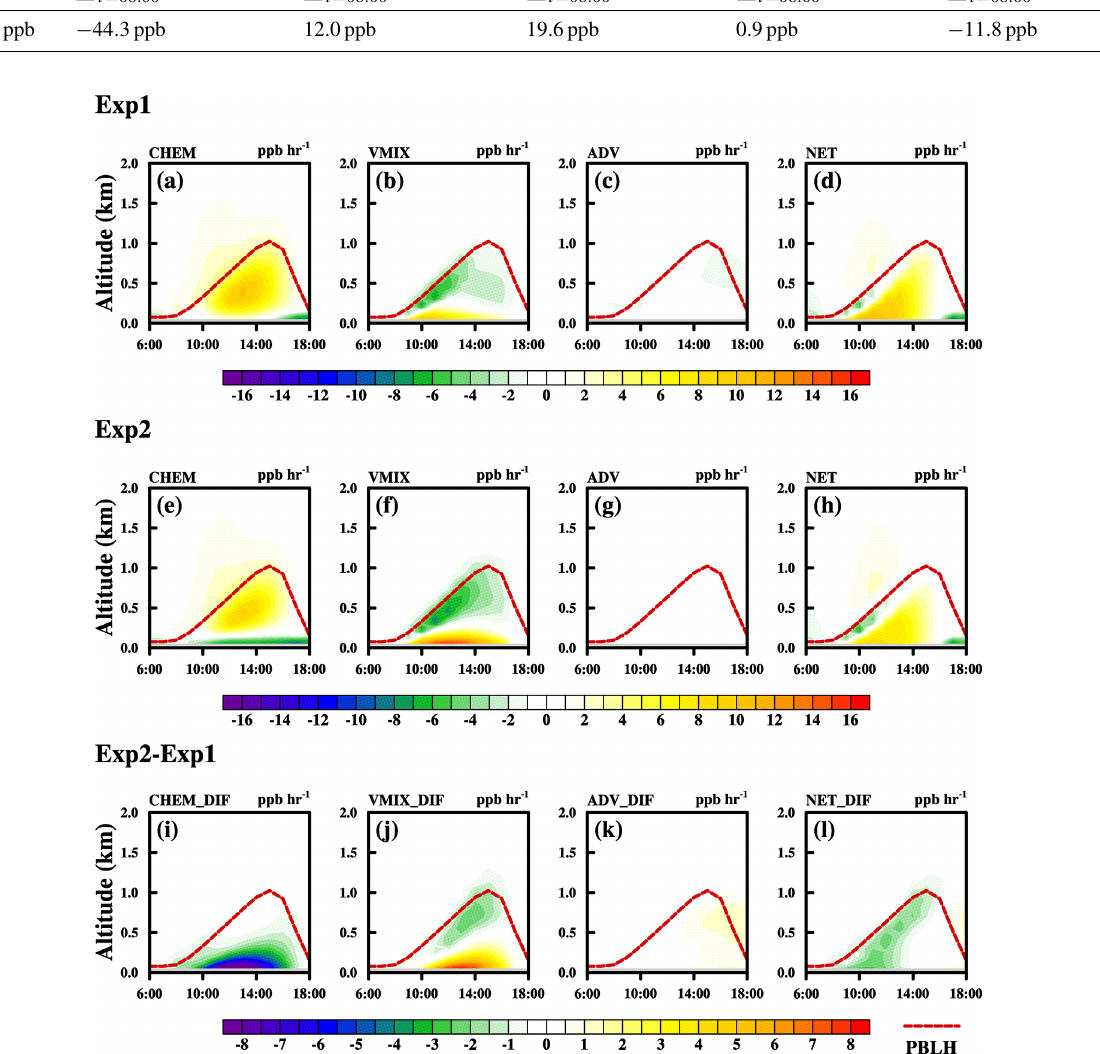
Figure 6. Averaged vertical distributions of process contributions as a function of time from 06:00 to 18:00LT. Data are spatially sampled. All the grids within the administrative regions of the four cities are collected and averaged which can represent the situation of the four cities. (a) – (d) Process contributions from Exp1; (e) – (h) process contributions from Exp2; (i) – (l) the changes in each process contribution due to aerosols (Exp2–Exp1). Dashed red lines denote